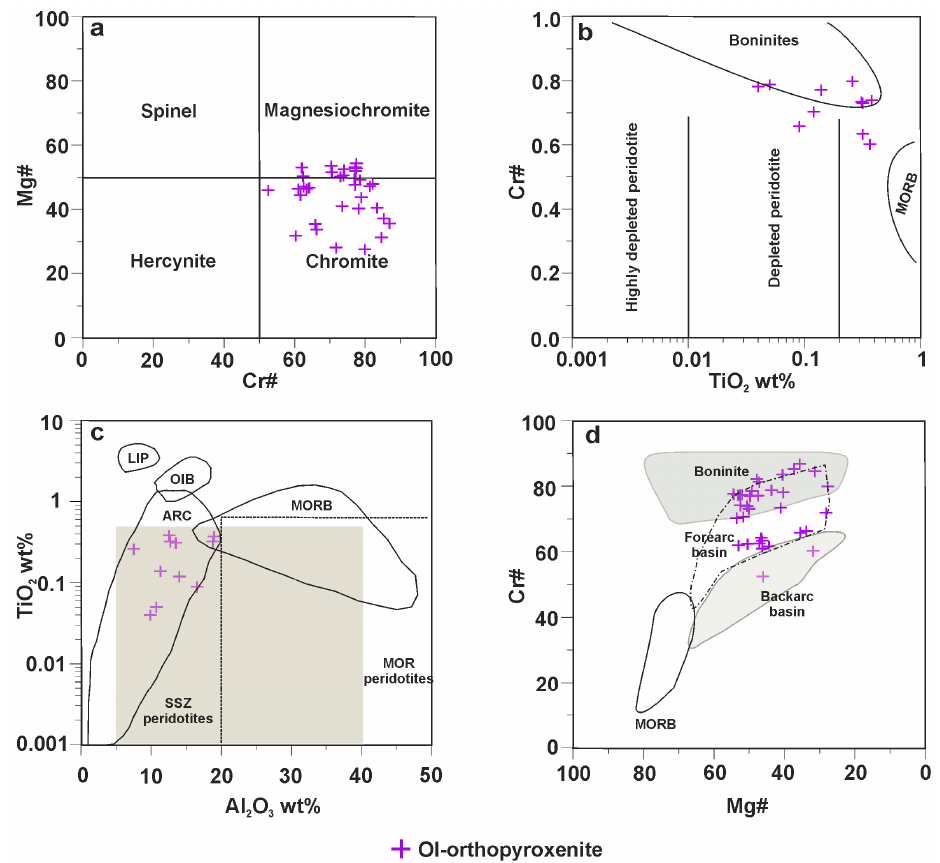
Figure 4. Compositional variations of the spinel-group minerals from the Ol-orthopyroxenites of the Veria-Naousa ophiolite: ( a ) Cr# vs. Mg# chemical classification diagram; ( b ) TiO 2 vs. Cr# diagram [40–42]; ( c ) Al 2 O 3 vs. TiO 2 diagram [43]; and ( d ) Mg# vs. Cr# diagram (boninite field after [32], MORB, forearc basin and backarc basin fields after [40]).